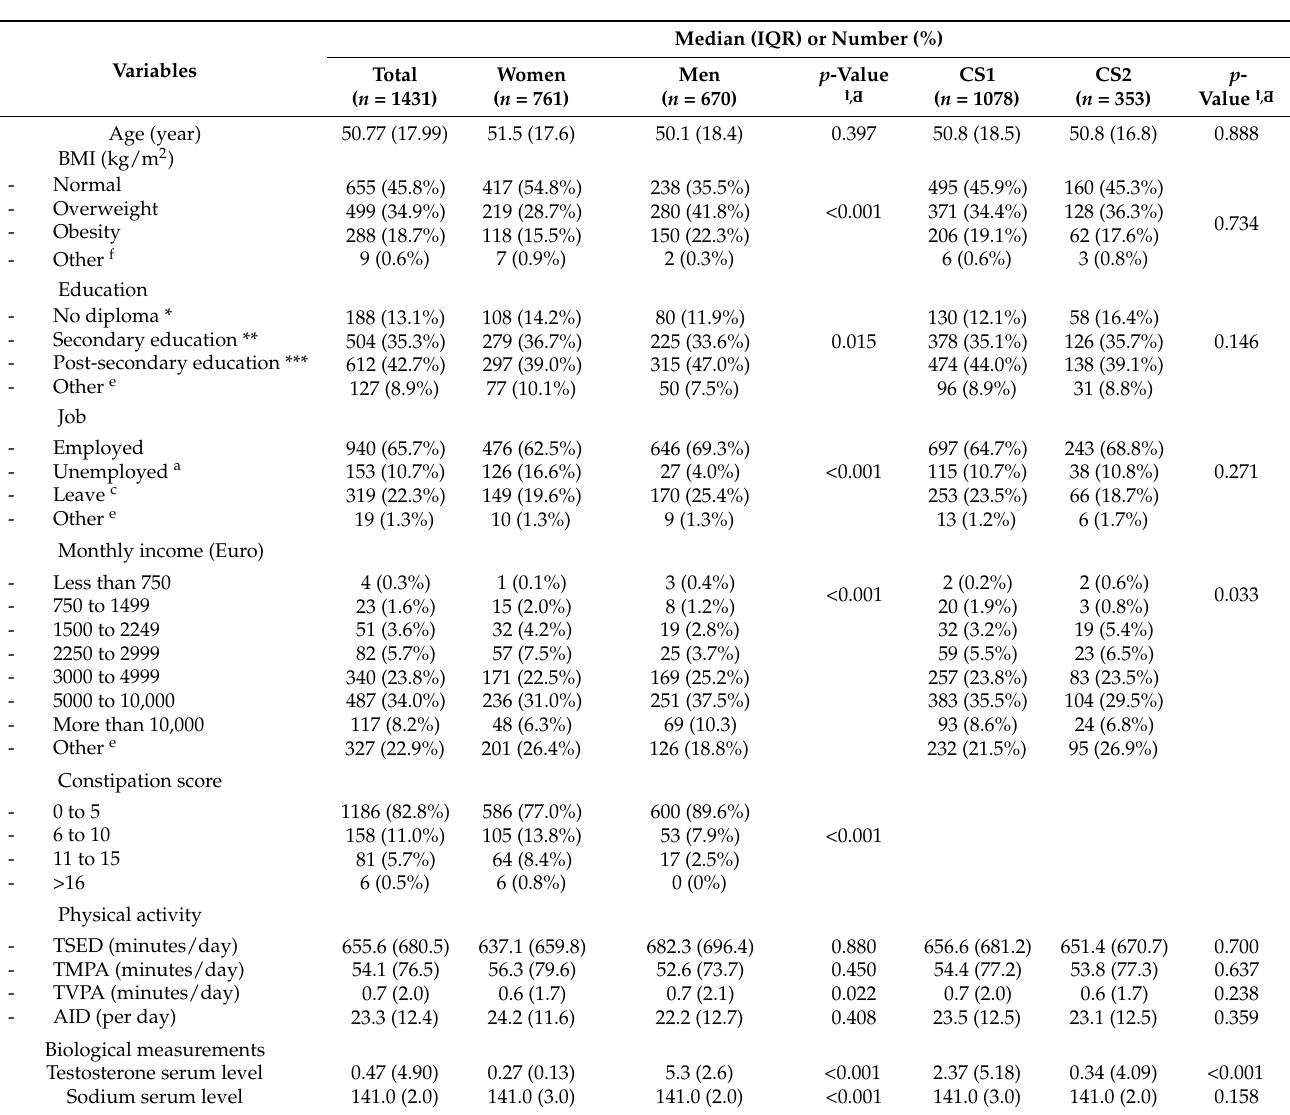
Table 2. Distribution of demographic, anthropometric, socioeconomic, and blood marker character ‐ istics of participants. ꝉ